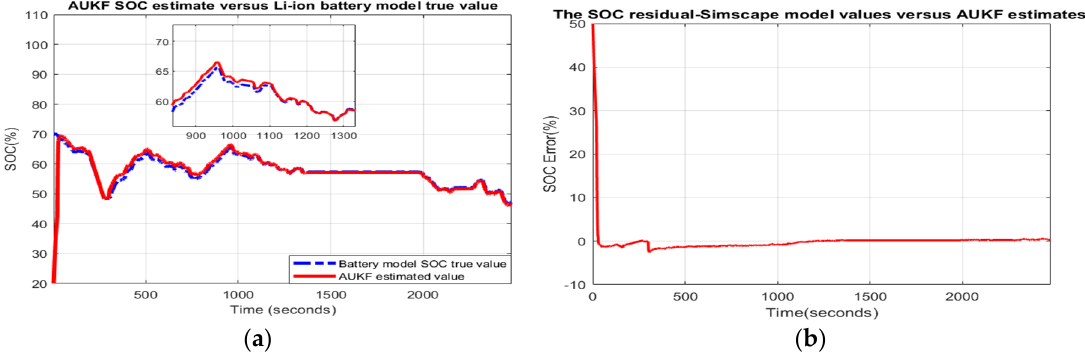
Figure 9. Robustness to simultaneous changes, SOCini = 0.2, and output temperature profile changes; ( a ) AUKF SOC value versus battery model true value; ( b ) SOC residual.